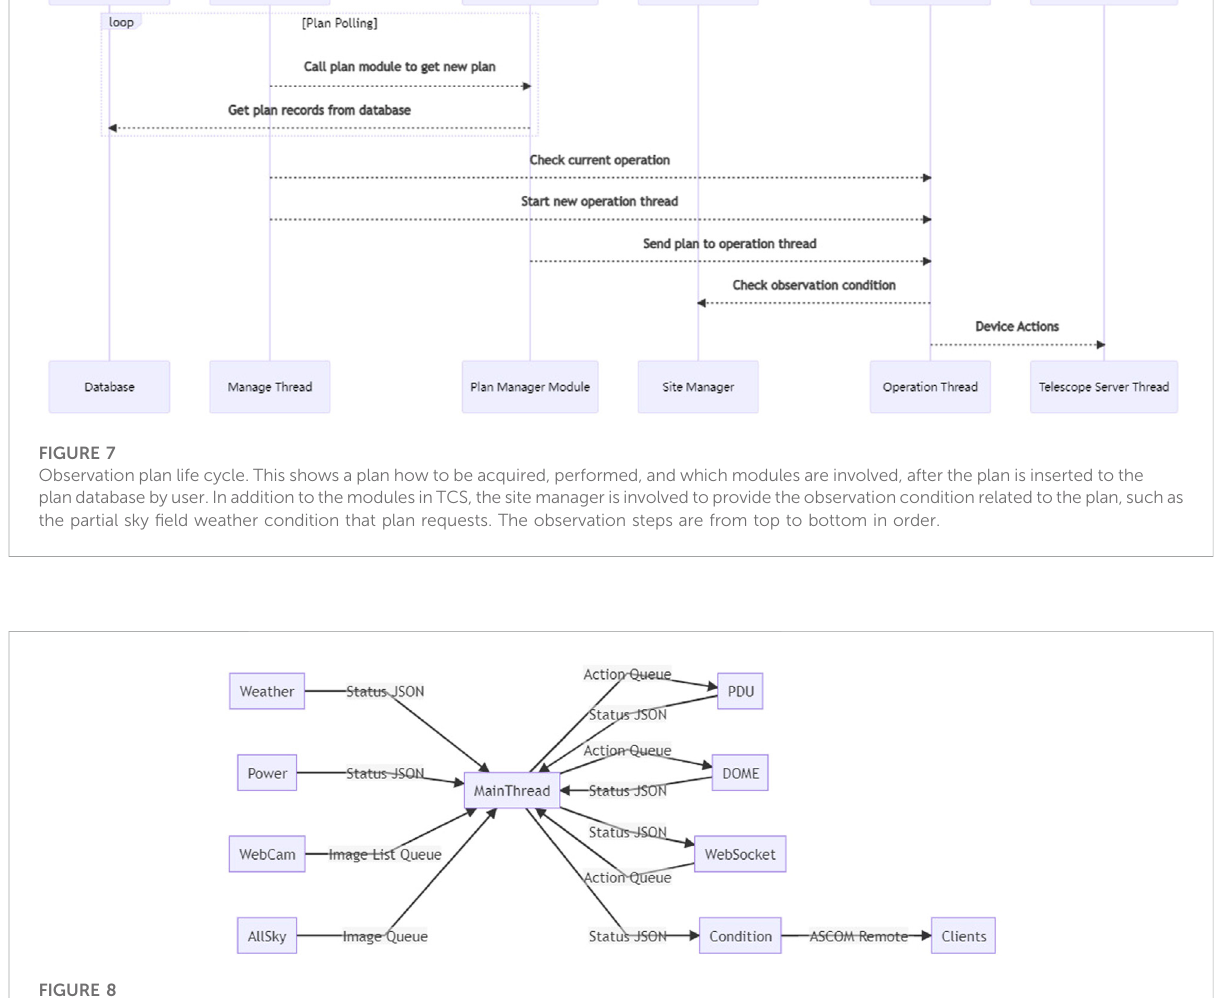
CHES site manager architecture. The main thread starts the other threads. Each one is responsible for one function, such as weather monitor device reading, dome controlling, and remote request answering. All the function are coded into the separated thread class so that it can be easily modi fi ed, extended or replaced to adapt different scenarios which usually do not have common platform